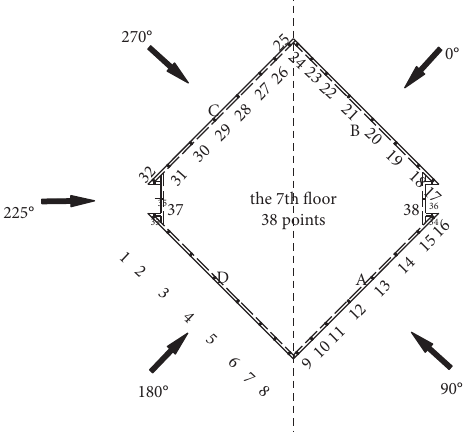
Figure 12: Cross section of the 7 th measurement level and definition of wind direction